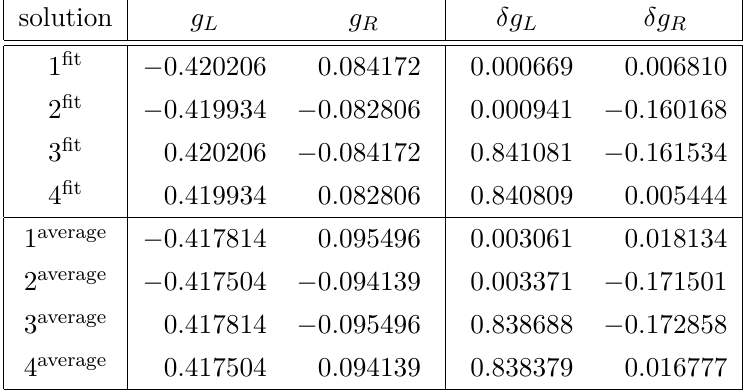
Table 1 . The results of equations (1.6) and (1.9) for g L and g R and the corresponding values of δg L and δg extracted from equations (1.3) and (1.4). The superscript “fit” corresponds to the input R values (1.10), while the superscript “average” corresponds to the input values (1.10a) and